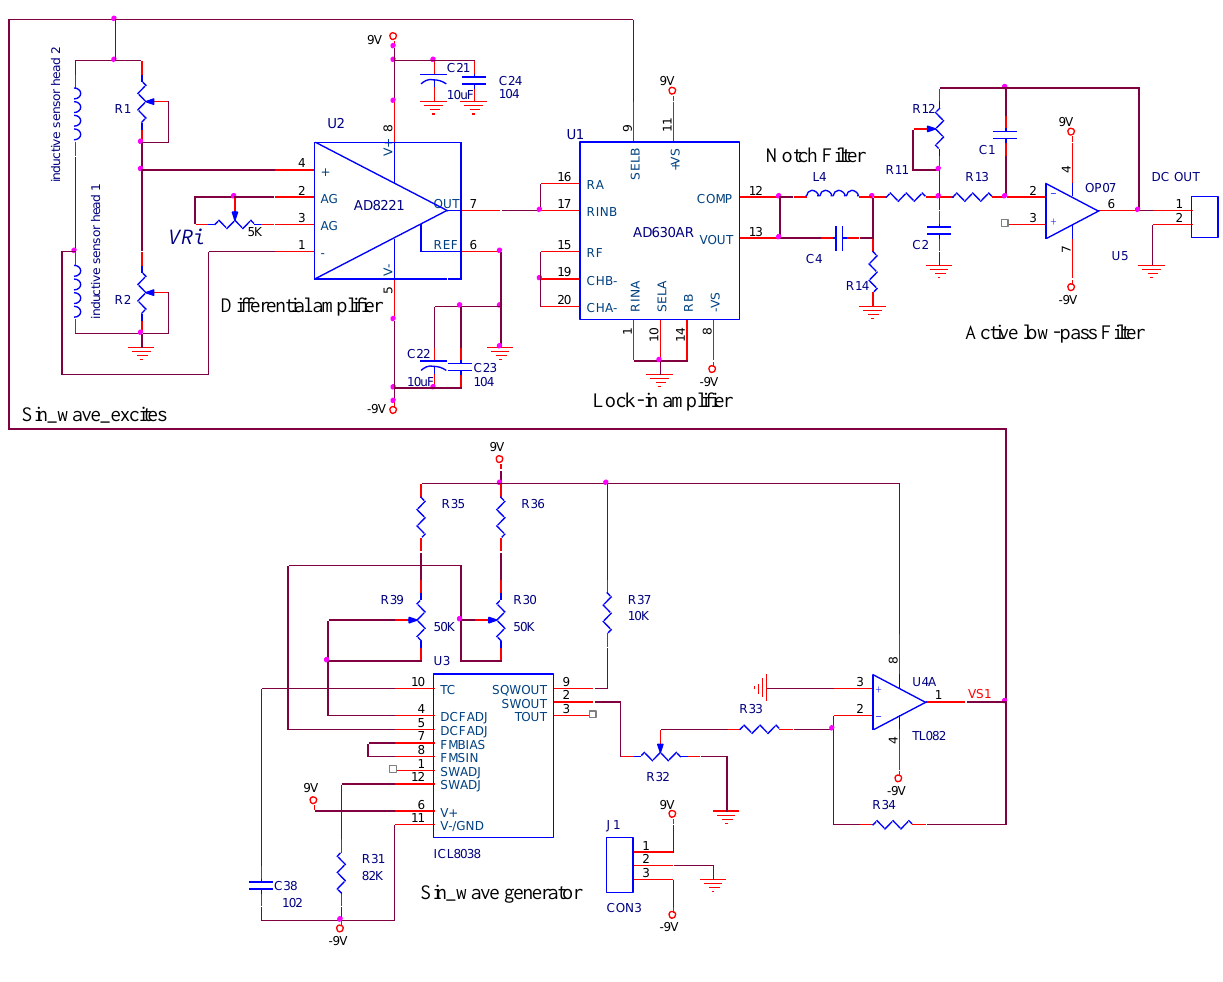
Figure 16. Full Schematic of inductive displacement sensor for AMB.